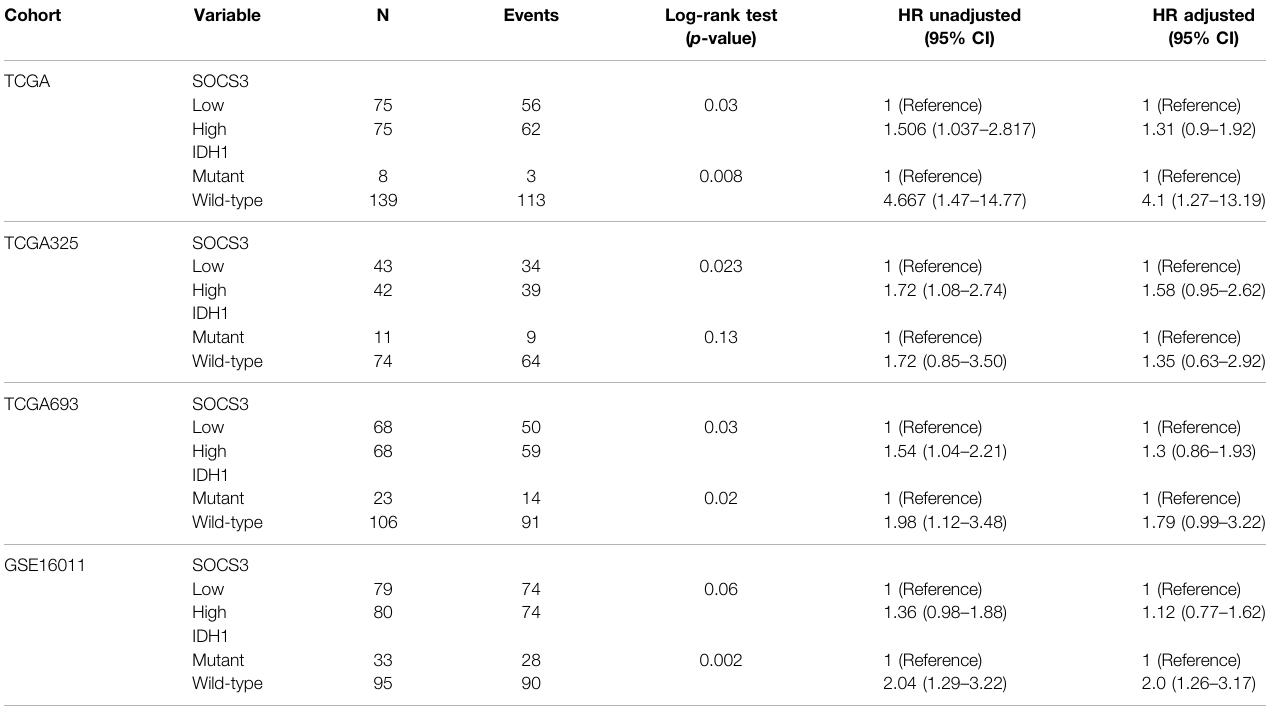
TABLE 2 | Prognostic value of the SOCS3 gene determined by multivariate Cox regression analysis in GBM. Cohort Variable